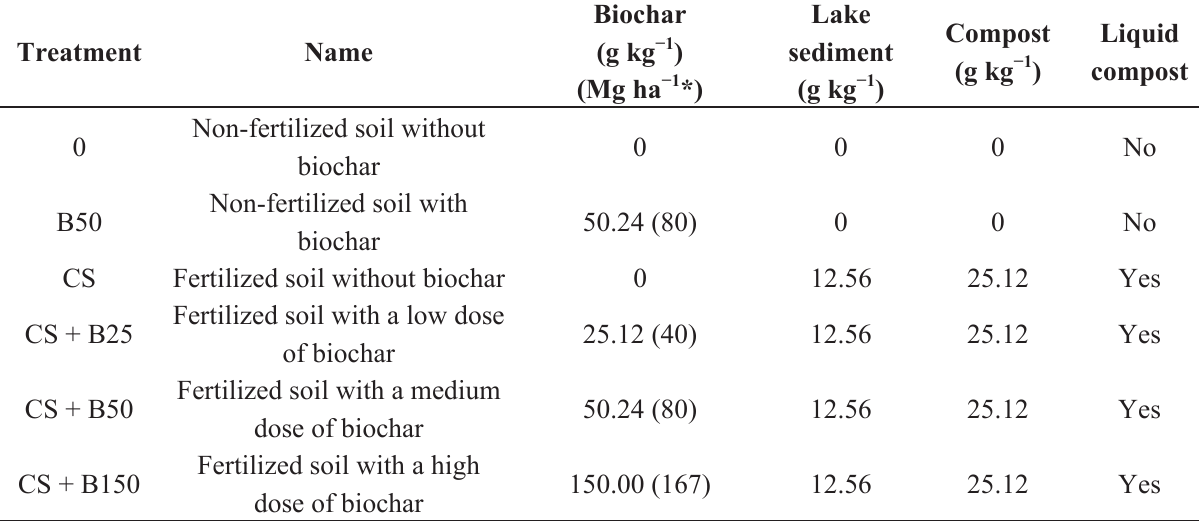
Table 1. Treatment description of soil, biochar and local organic fertilizer addition.